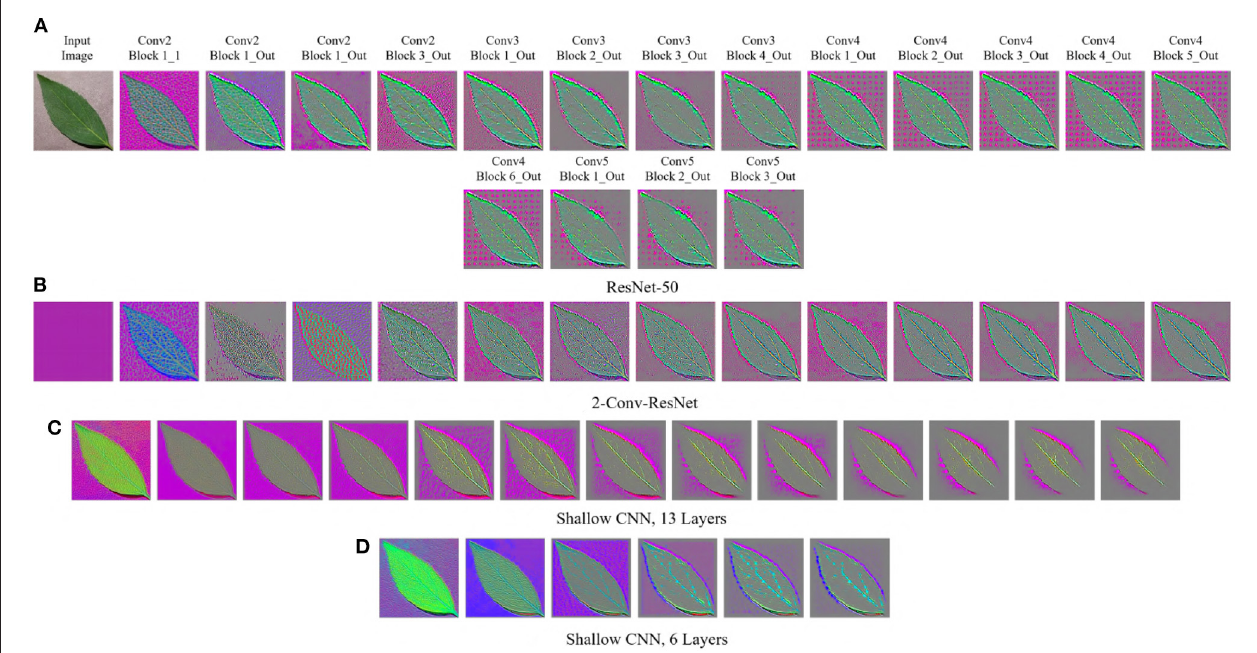
FIGURE 3 | GBP-based visualization of the intermediate layers (left to right) of different CNN models for Bean leaf of the Plant Village dataset. The top-left image of (A) is the input image for all models. (A) ResNet-50. (B) 2-Conv-ResNet. (C) Shallow CNN, 13 layers. (D) Shallow CNN, 6 layers.